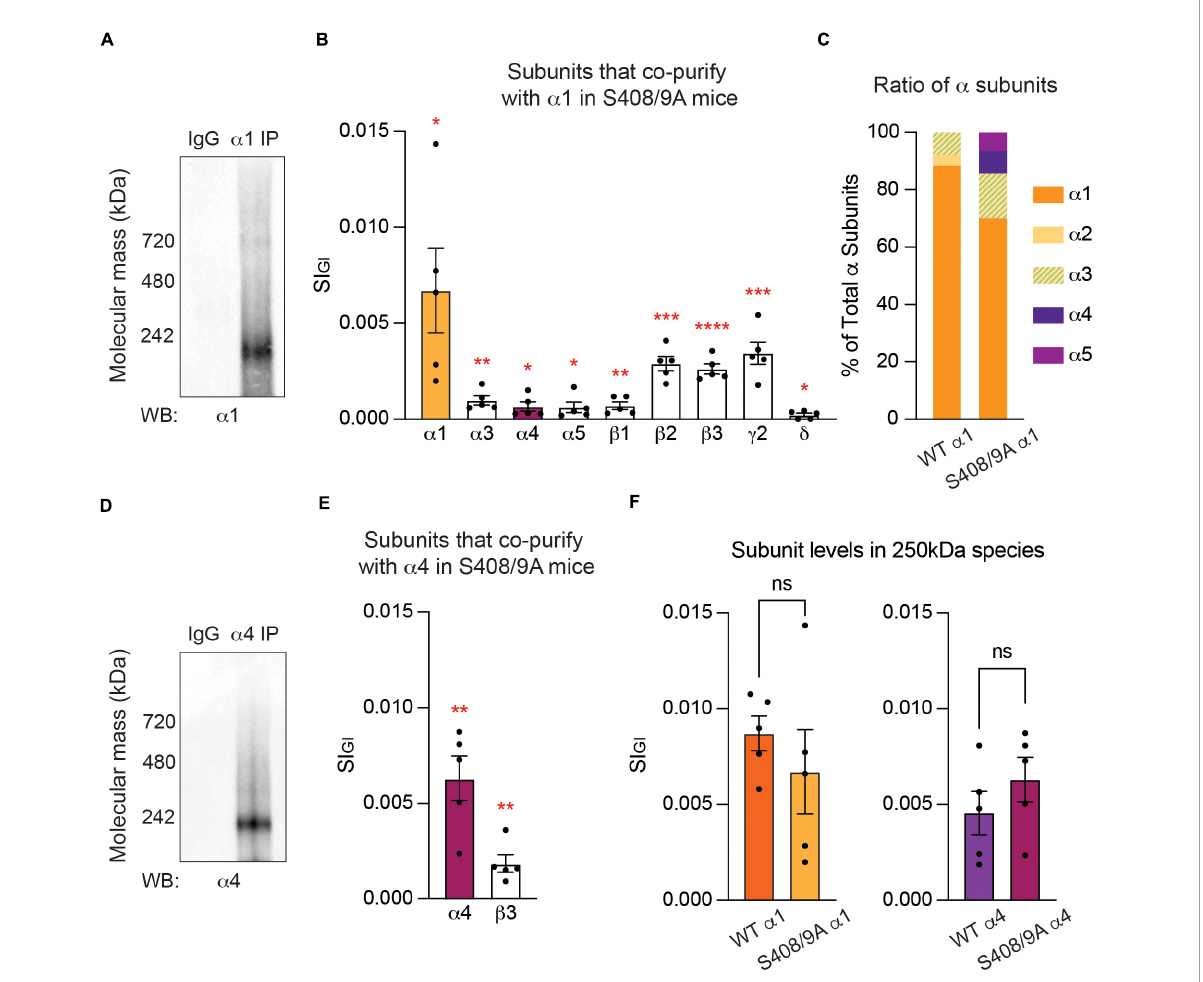
FIGURE6 Mutation of S408/9 leads to the formation of α 1 α 4-containing GABA A Rs. (A) Purified PM from S408/9A mice were exposed to non-immune control IgG or the α 1 subunit antibody and probed for the α 1 subunit. Major bands at 250 and 720 kDa were observed. (B) Quantitative analysis of the contents of the 250 kDa band revealed that the α 4 and α 5 subunits are significantly enriched in α 1-containing GABA A Rs in S408/9A mice, along with the α 1, α 3, β 1–3, γ 2, and δ subunits (* p < 0.05, ** p < 0.01, *** p < 0.001, **** p < 0.0001, n = 5 replicates). (C) Contribution of each α subunit variant to the total amount of α subunits is compared between α 1-containing GABA A Rs from WT and S408/9A mice. With the S408/9A mutation, the percentages of the α 1 and α 2 subunits decrease whereas those of the α 3, α 4, and α 5 subunits increase. (D) The α 4 subunit antibody recognized a major band at 250 kDa in purified α 4-containing GABA A Rs from S408/9A mice. (E) In α 4-containing GABA A Rs from S408/9A mice, only the α 4 and β 3 subunits are significantly enriched (** p < 0.01, n = 5 replicates). (F) The S408/9A mutation does not affect the efficacy of the purification of either α 1- or α 4-containing GABA A Rs (ns ≥ 0.05, n = 5